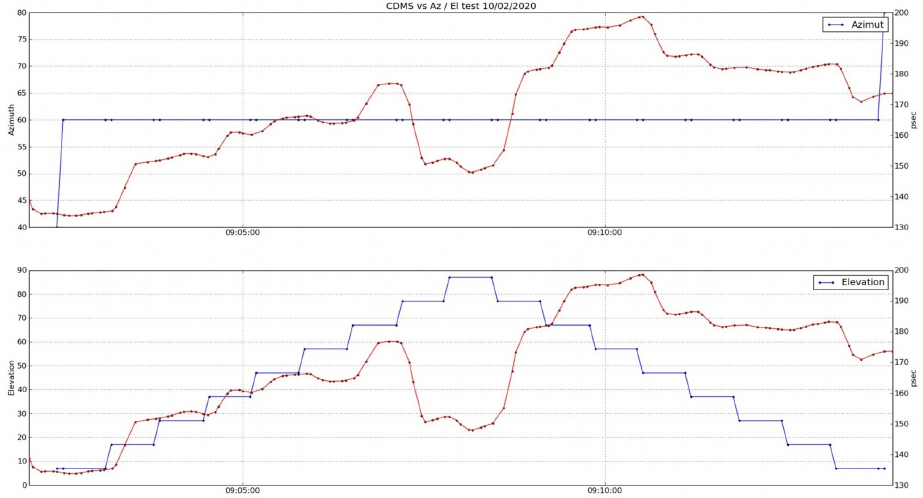
Figure 24. Zoom of cable delay versus azimuth ( top ) and elevation ( bottom ) during the first part of the